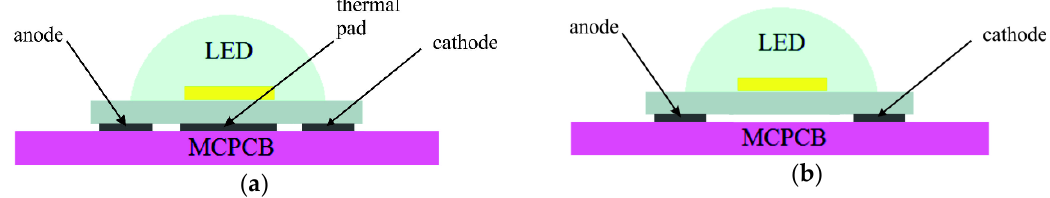
Figure 5. The method of installing LED sources: ( a ) with all pads soldered and ( b ) without the thermal pad soldered.